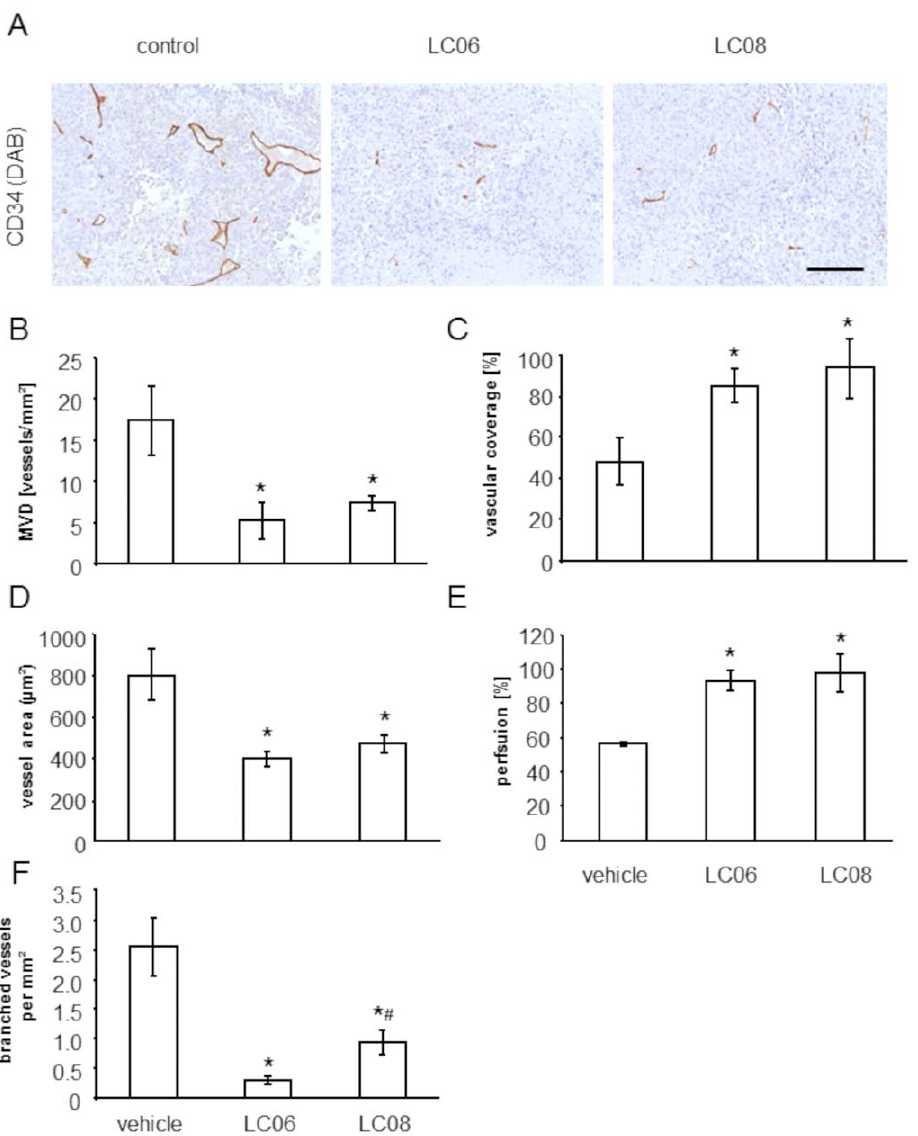
Figure 2. Effect of LC06 and LC08 treatment on MVD ( A and B ) , vascular coverage ( C ) , vessel area ( D ) , perfusion ( E ) and vessel branching ( F ) in Colo205 tumors. ( A ) Representative pictures of CD34-stained Colo205 tumors (mean 800 mm 3 ). ( B ) Quantitative analysis of tumor microvessel density (MVD). MVD was quantified in CD34-stained whole tumor slides. LC06 and LC08 treatment led to a significant reduction of intratumoral MVD (n=5, *p , 0.05 compared to control, Student’s t-test). ( C ) Quantification of vessel coverage calculated as the percentage of desmin-positive vessels in relation to CD34-positive endothelial cells staining in six random regions of 1000 6 1000 m m per tumor slide. LC06 and LC08 treated tumors showed increased vessel coverage by desmin positive pericytes (n=5 mice per group, *p , 0.05 compared to control, Student’s t-test). ( D ) The average vessel area of intratumoral microvessels were significantly reduced in tumors treated with LC06 and LC08 (n=5, *p , 0.05 compared to control, Student’s t-test). ( E ) Perfusion was assessed based on analysis of TRITC-lectin perfusion and CD34-positive staining in six random regions of 1000 6 1000 m m per tumor slide. Almost all remaining intratumoral microvessels were perfused in LC06 (93%) and LC08 (97%) treated tumors compared to control (56%) (n=5 mice per group, *p , 0.01). ( F ) Number of branched intratumoral microvessels was counted in six random regions of 1000 6 1000 m m per tumor slide and calculated per mm 2 and was significantly reduced in tumors treated with LC06 and LC08. LC06 treatment resulted in stronger inhibition of vessel branching compared to pan-Ang-2/-1 treatment via LC08 (n=5, *p , 0.01 compared to control; # p , 0.01 compared to LC08, Student’s t-test). Results are expressed as mean 6 SEM. Scale bars represent 500 m m.